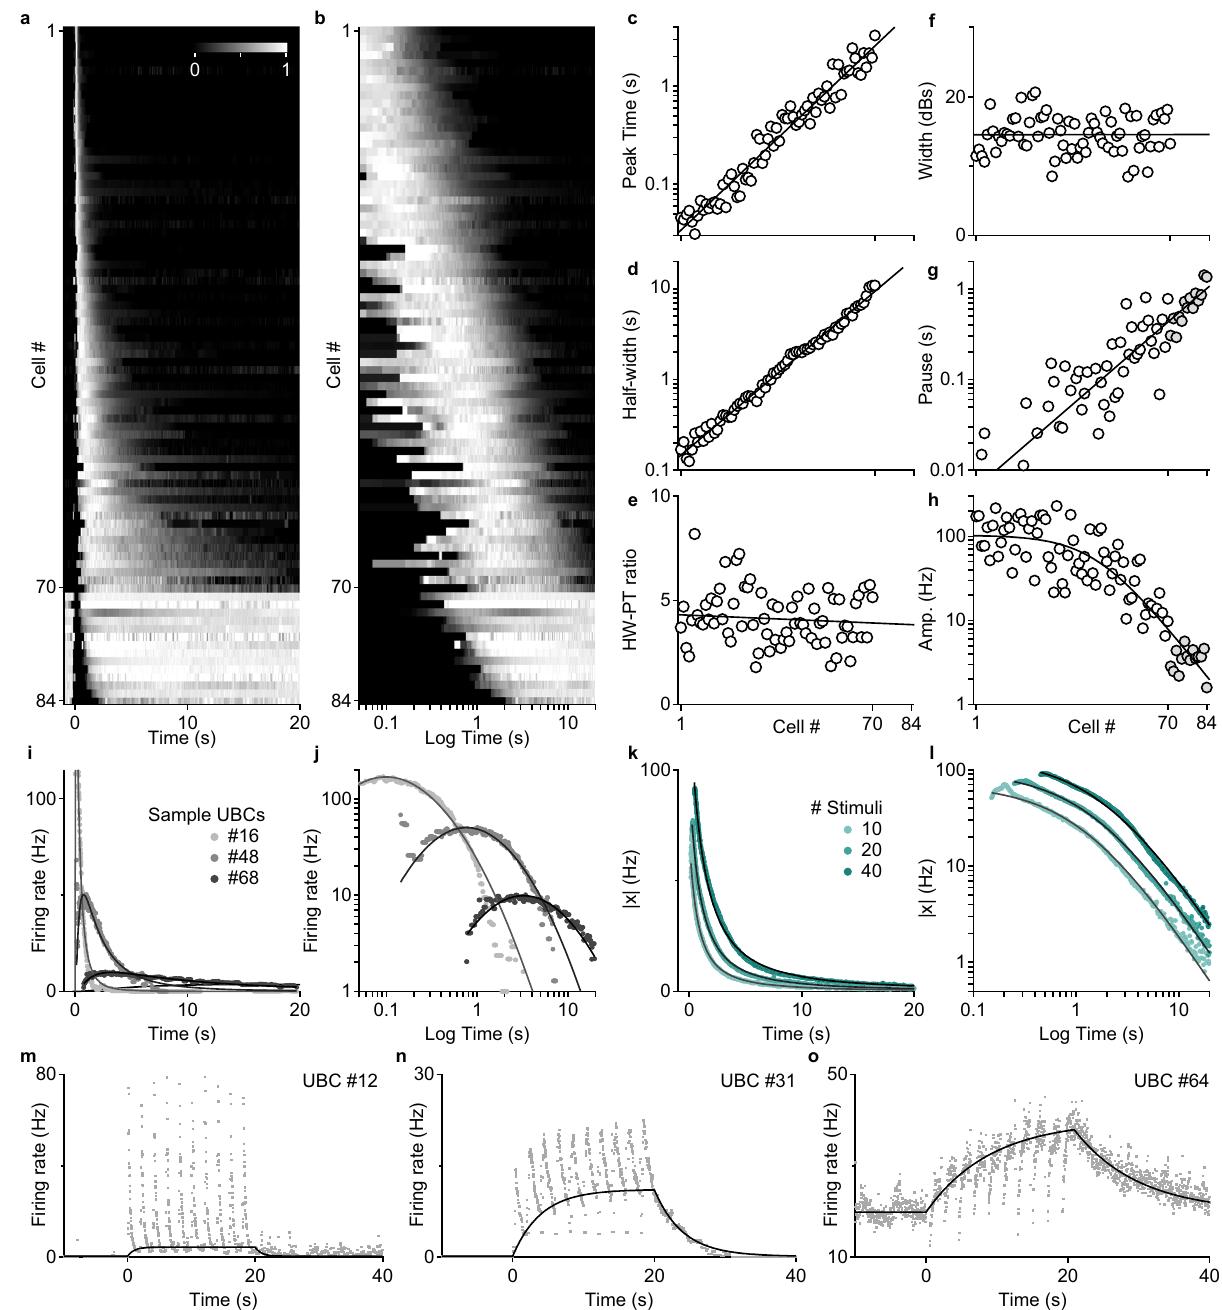
Fig. 6 UBC population generates a continuum of multi-scale temporal representations. a All normalized responses displayed as a sorted heat map in linear time ( n = 84). b The same sorted heat map displayed in logarithmic time ( t = 0 at stimulus offset). c Peak-time vs. cell #, linear fi t on the log 10 data (black). d Half-width of response vs. cell #, linear fi t on the log 10 data (black). e Half-width to peak-time ratio vs. cell #, linear fi t (black). f Width of Gaussian fi ts of responses on a logarithmic time scale vs. cell #, linear fi t (black). g Pause time vs. cell #, linear fi t on the log 10 transformed data (black). h Amplitude of response vs. cell #, recti fi ed linear fi t on the log 10 data (black). i Sample instantaneous fi ring rate in three UBCs (gray dots) and log-Gaussian fi ts (black). j Same as in i but in a log-log plot. k Amplitude of population response over time for different numbers of stimuli (turquoise dots, 10x, 20x, and 40×100Hz) and shifted power- law fi ts (black lines). l Same as in k in a log-log plot to better illustrate the power-law decay in the tail, for 10, 20, and 40 stimuli. The critical exponent α = − 1.47 with 95% CI of ( − 1.51, − 1.44). m Representative response of a fast UBC to a 10×0.5Hz sequence of 10×100Hz MF bursts. n Response of an intermediate UBC to the same sequence of MF bursts o . Response of a slow UBC to the same sequence of MF